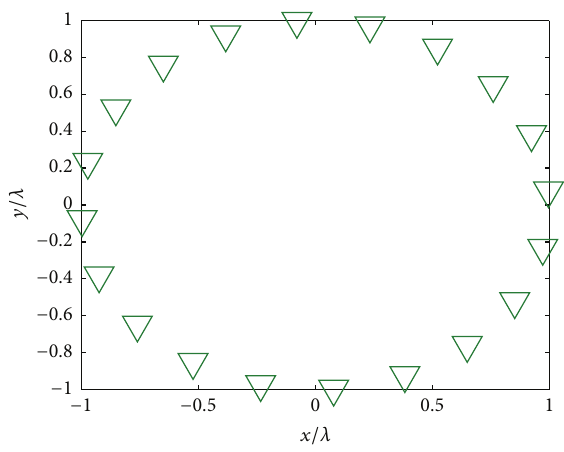
Figure 2: Source/observation